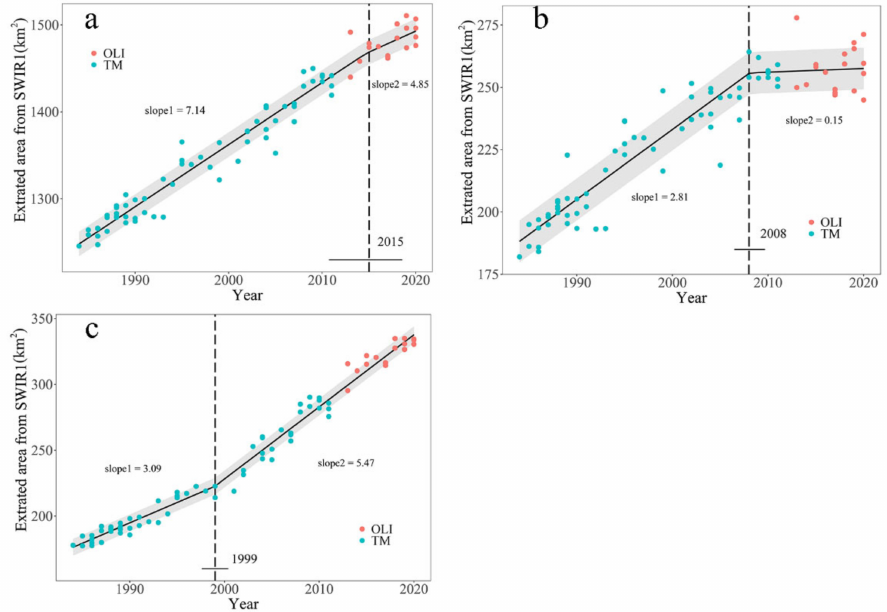
Figure 5. Segmented linear regression of the shorelines of the whole of Chongming Island ( a ), the eastern shoreline ( b ), and the northern shoreline ( c